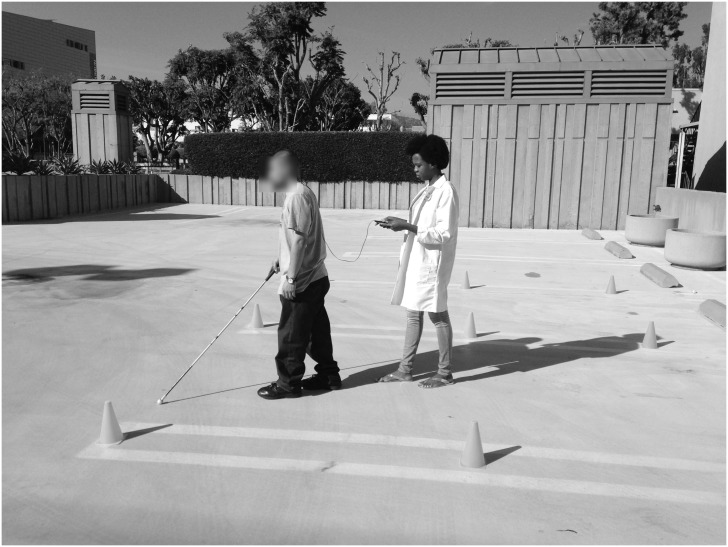
Outdoor testing with the Audible Mobility Feedback System.Subject being guided by the researcher using the aMFS during an outdoor testing session.